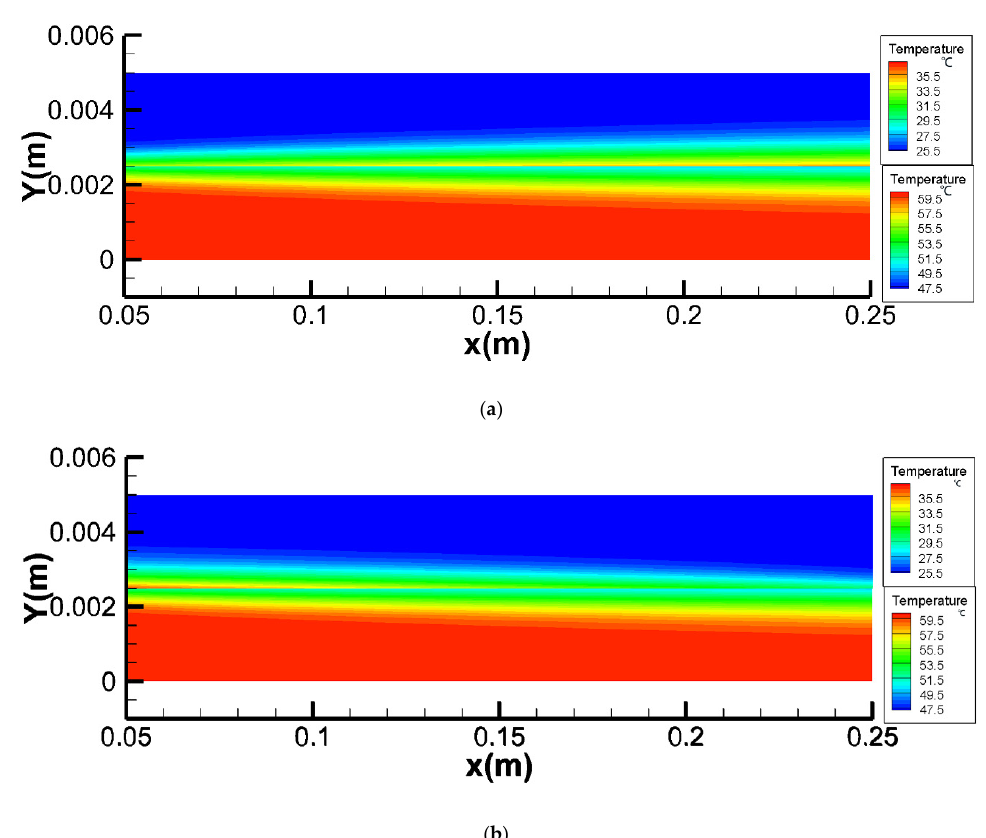
Figure 8. Temperature fields for co- and counter-current operations (different color scales were used in the permeate and feed channels, T f = 60 °C, T p = 25 °C, v f , v p = 0.15 m/s, c f = 24.2 wt.%). ( a ) co-current operation. ( b ) counter-current operation.